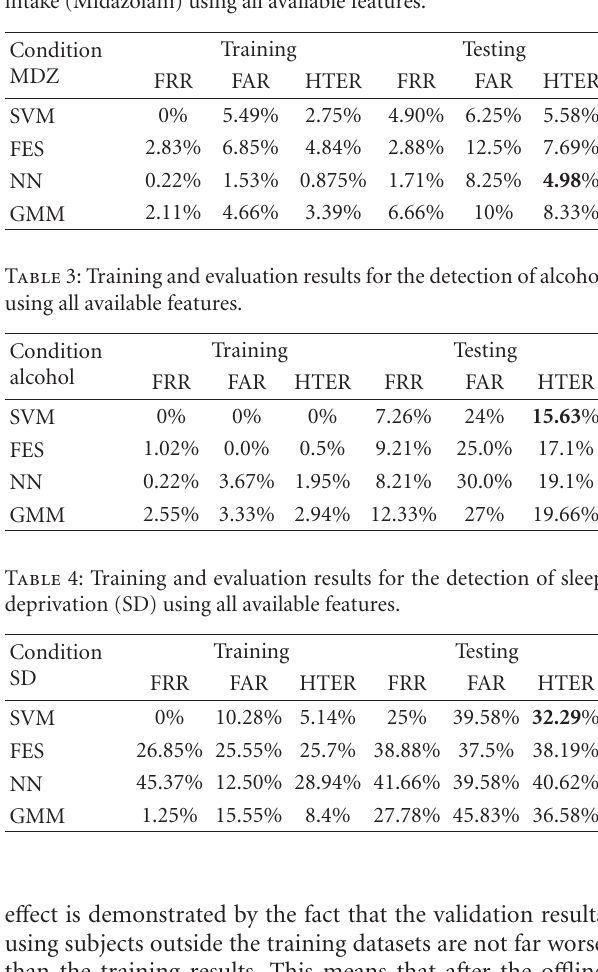
Table 2: Training and evaluation results for the detection of drug intake (Midazolam) using all available features.